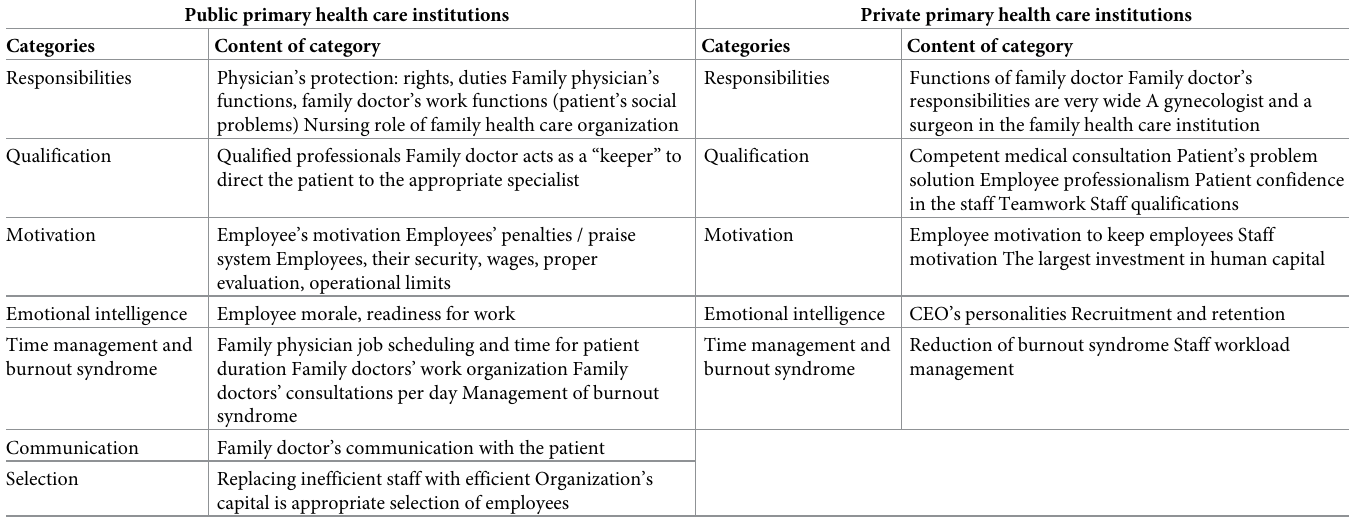
Table 3. Categories of perspective “management of human